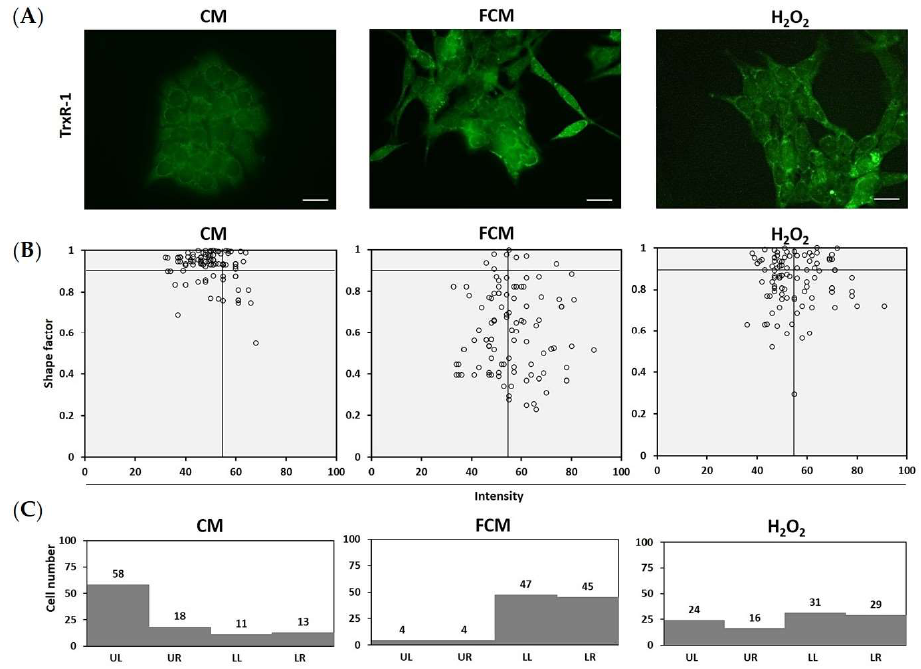
Figure 5. TrxR-1 relates to mesenchymal morphology in fibroblast induced HCT116 cells. ( A ) TrxR-1 expression was detected with immunofluorescence (magnification 400×). The intensity and mor- phology of HCT116 cells were analyzed with image J software. ( B ) The data represented with dot plot of shape factor and the intensity of TrxR-1 expression (n = 100). ( C ) Bar graphs represent the proportion of cell number in each quadrant (UL = upper-left, UR = upper-right, LL = lower-left and LR = lower-right). CM = complete media (control), FCM = fibroblast-cultured media, and 20 µ M H 2 O 2 as positive stress